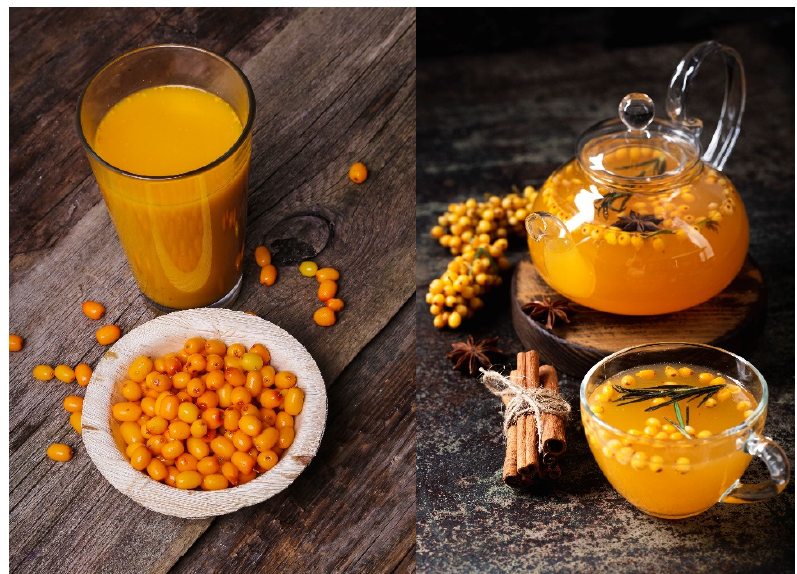
Figure 2. Examples of sea buckthorn in the food industry; juice and tea brewed from berries [31,32].